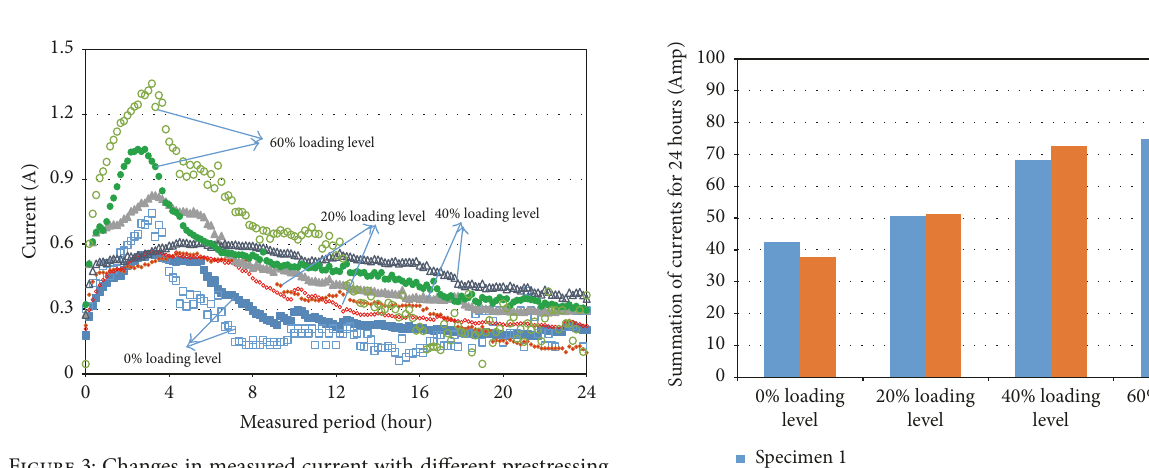
Figure 3: Changes in measured current with different prestressing level.